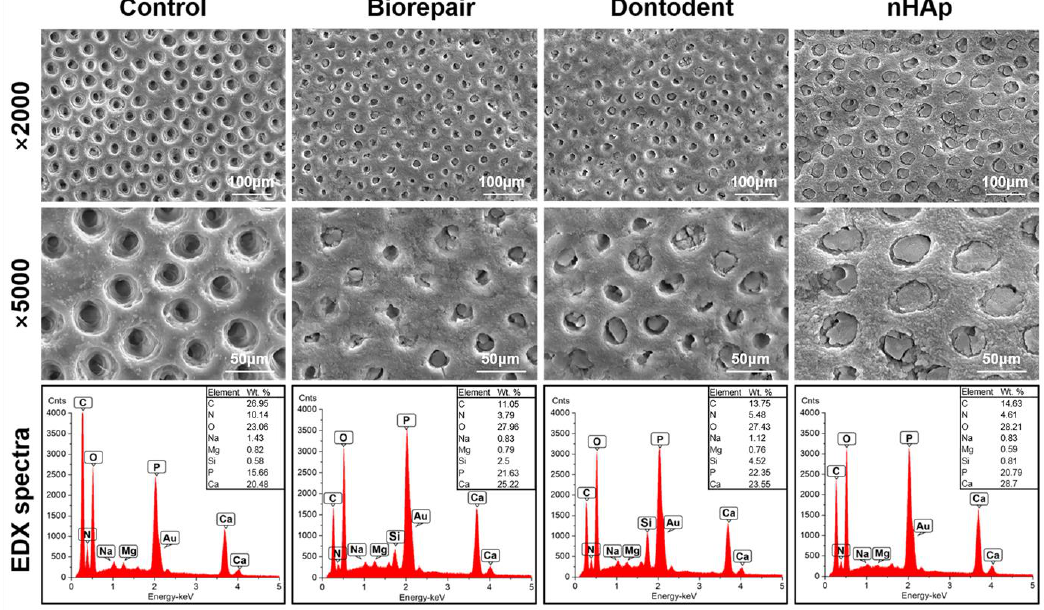
Figure 4. SEM image observation and EDX spectrum of dentin surface after desensitization treatment (×2000 and ×5000).